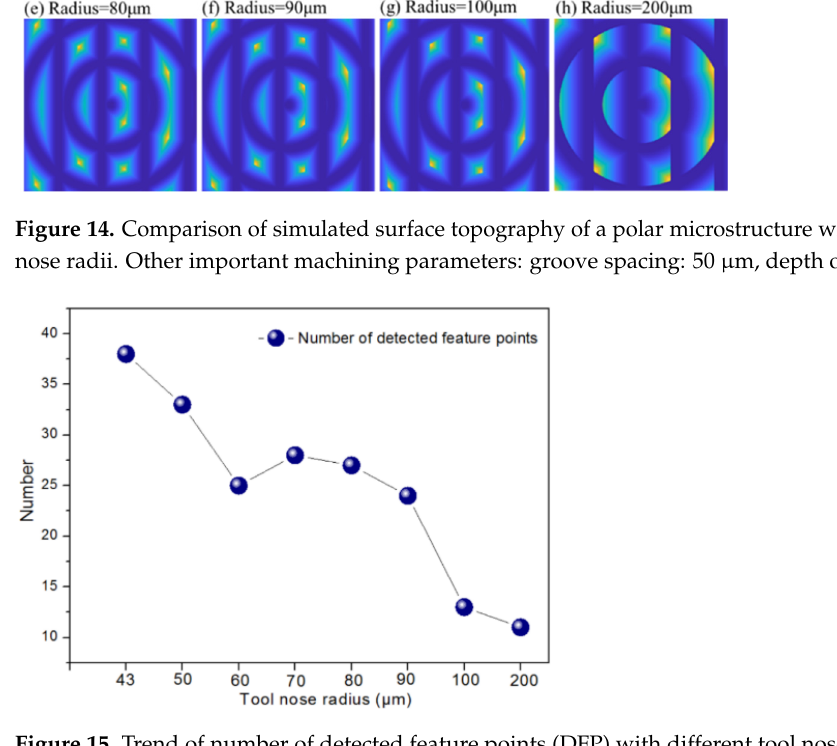
Figure 14. Comparison of simulated surface topography of a polar microstructure with different tool nose radii. Other important machining parameters: groove spacing: 50 μ m, depth of cut: 5 μ m.